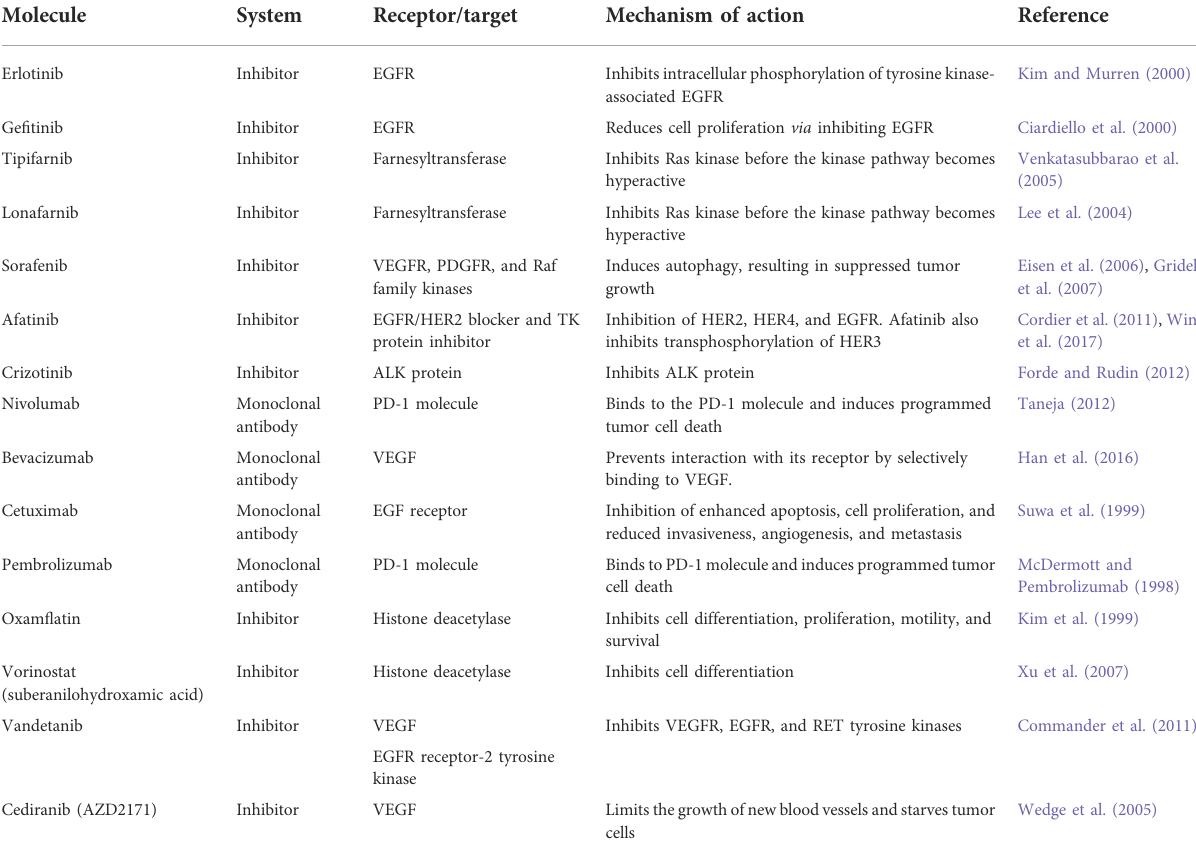
TABLE 1 Novel and current immunotherapies available for lung cancer in clinical trials and in the research